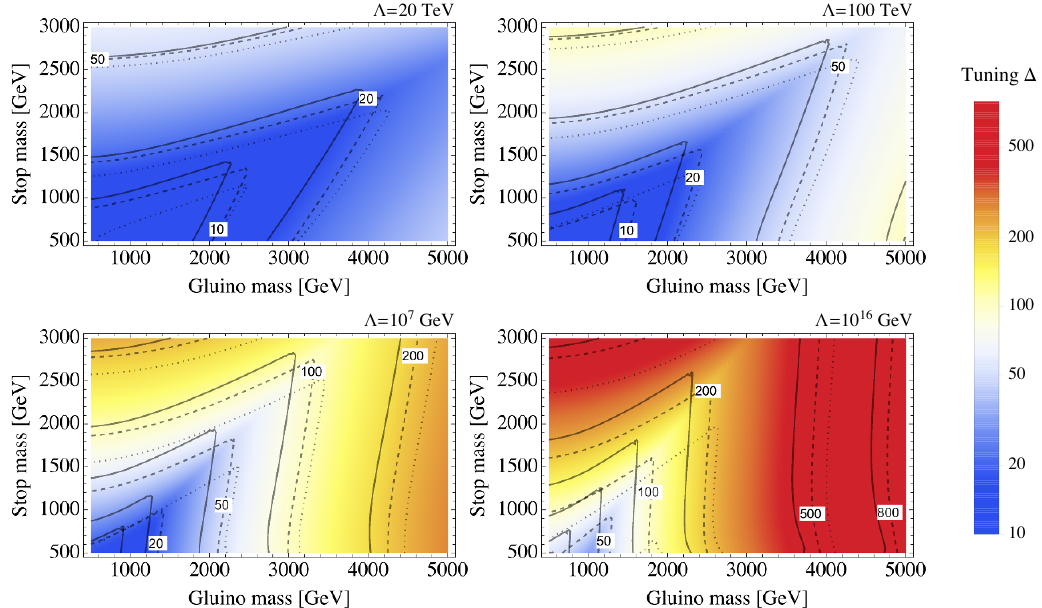
Figure 7 . Level of Higgs (cid:12)ne-tuning in the gluino-stop mass plane, for di(cid:11)erent values of the messenger scale (cid:3) = 20 TeV (top, left), 100 TeV (top, right), 10 7 GeV (bottom, left) and 10 16 GeV (bottom, right). Di(cid:11)erent values of (cid:12)ne-tuning are color-coded according to the legend on the right, with shades of blue corresponding to (cid:12)ne-tuning levels close to 10%, whites in the few percent range, and yellows/reds for sub-percent (cid:12)ne-tuning (for de(cid:12)niteness, the color-coding corresponds to 1st and 2nd generation squarks at 5 TeV). Contours for speci(cid:12)c values are also provided, with solid, dashed and dotted contours corresponding to squarks degenerate with the stops and 5 and 10 TeV.